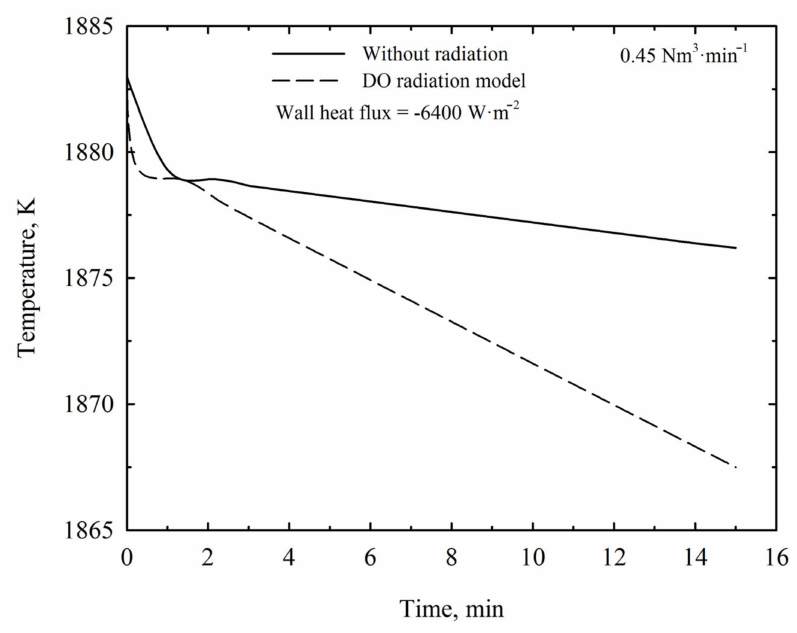
Figure 7. Influence of radiation mechanism on the steel temperature